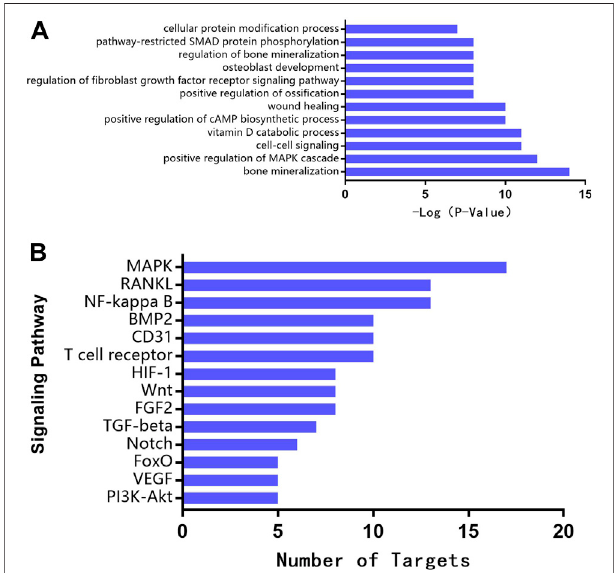
FIGURE 2 | (A) Biological function annotation (B) Pathway enrichment analysis for therapeutic targets of TFRD.